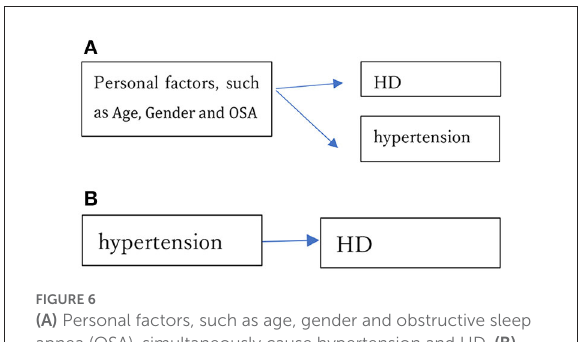
FIGURE6 (A) Personal factors, such as age, gender and obstructive sleep apnea (OSA), simultaneously cause hypertension and HD. (B) Hypertension directly causes